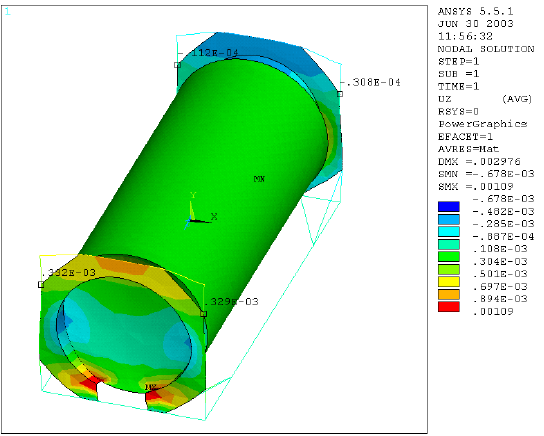
Figure 8. Displacement along z.